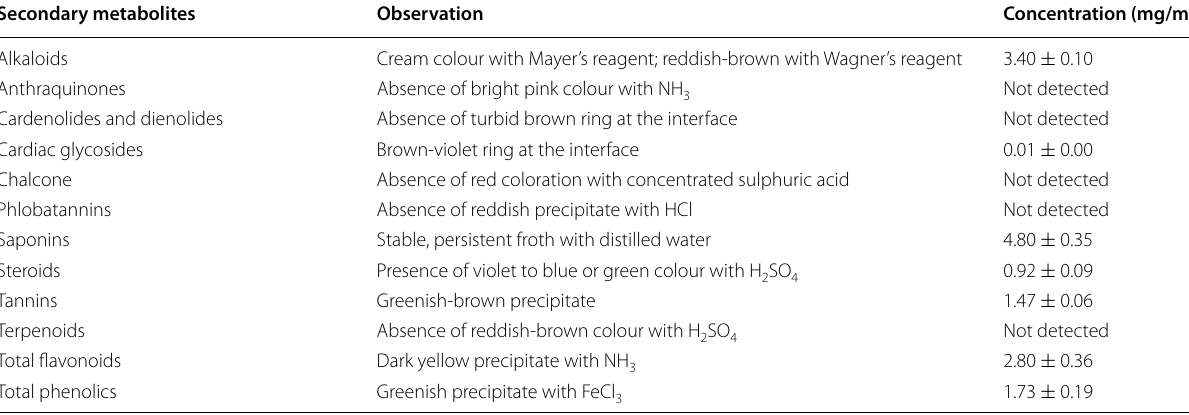
Values are means of three determinations